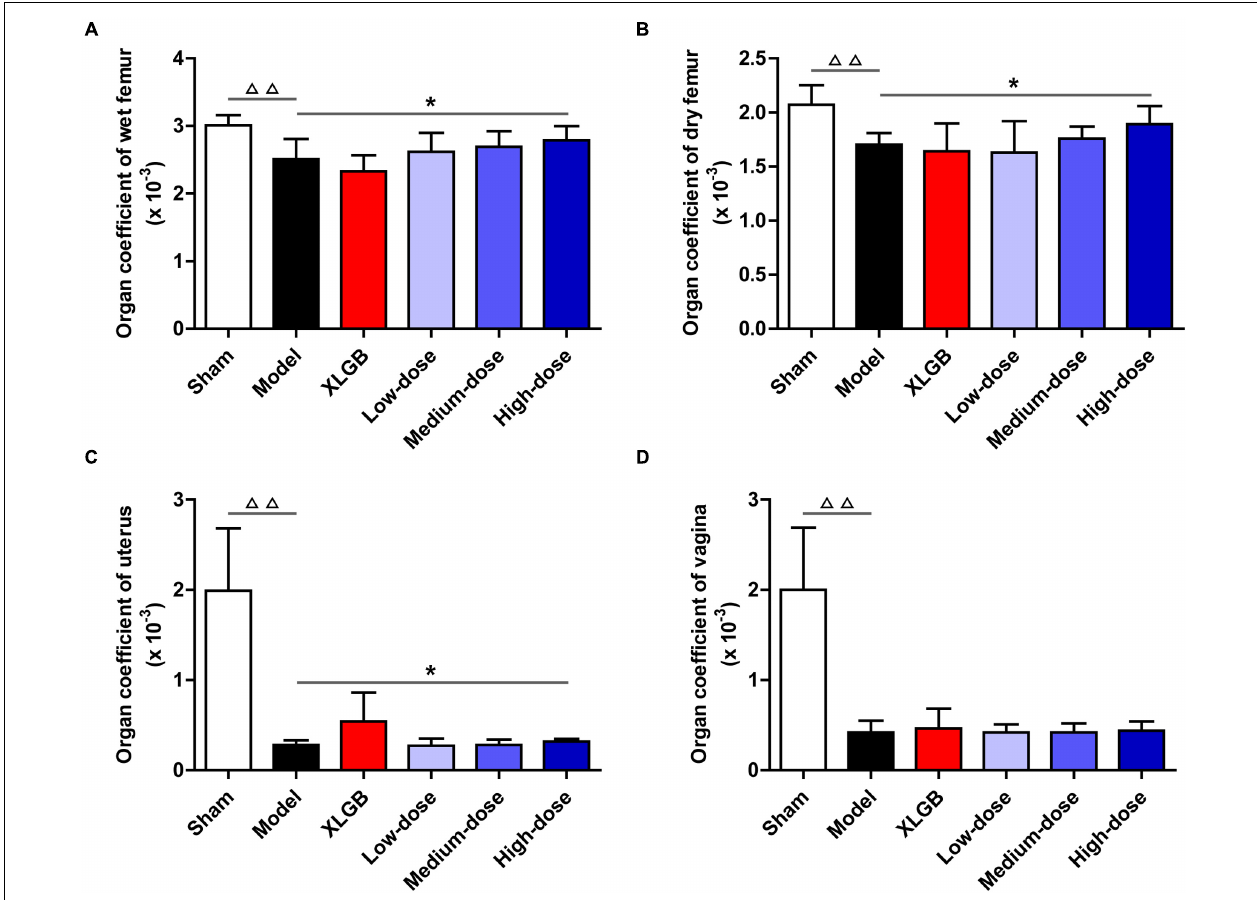
FIGURE 2 | Pu-erh tea extract improved organ coefficients in OVX rats. Organ coefficients of the wet femur (A) , dry femur (B) , uterus (C) , and vagina (D) in each group. All data are presented as the mean ± SEM ( n = 10). (cid:77)(cid:77) P < 0.01 versus the sham group; and ∗ P < 0.05 versus the model group.